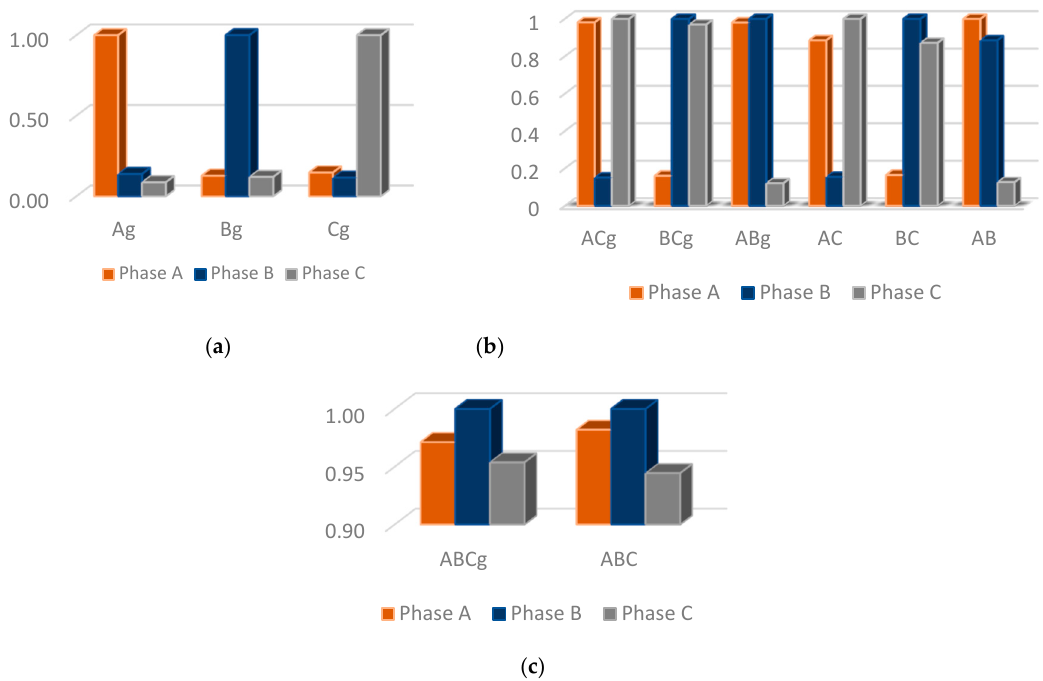
Figure 5. Illustrative example with the means of normalized current signals. Short-Circuits: ( a ) single-phase; ( b ) two-phase; and ( c ) three-phase.